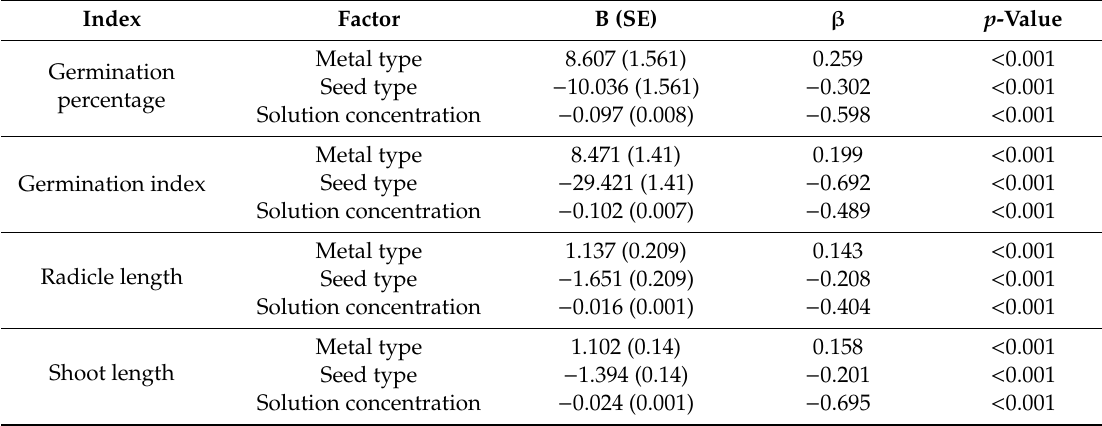
Table 1. Multivariate analysis of correlates associated with germination percentage and index of dimorphic seeds of Suaeda salsa , radicle and shoot length of seedlings grown from both types of seeds.